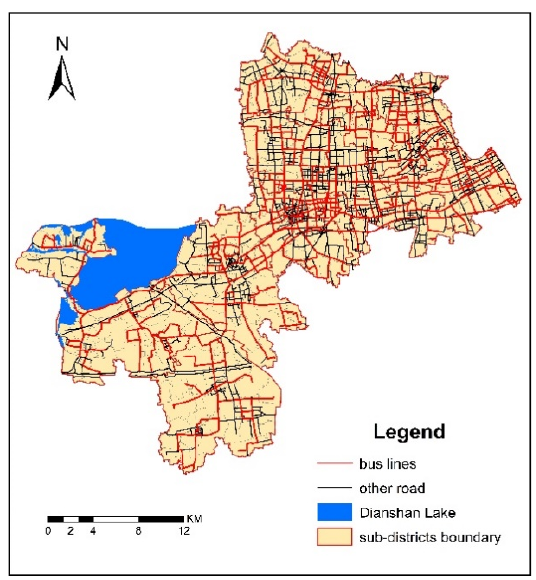
Figure 4 . The bus lines in Qingpu. Figure 4. The bus lines in